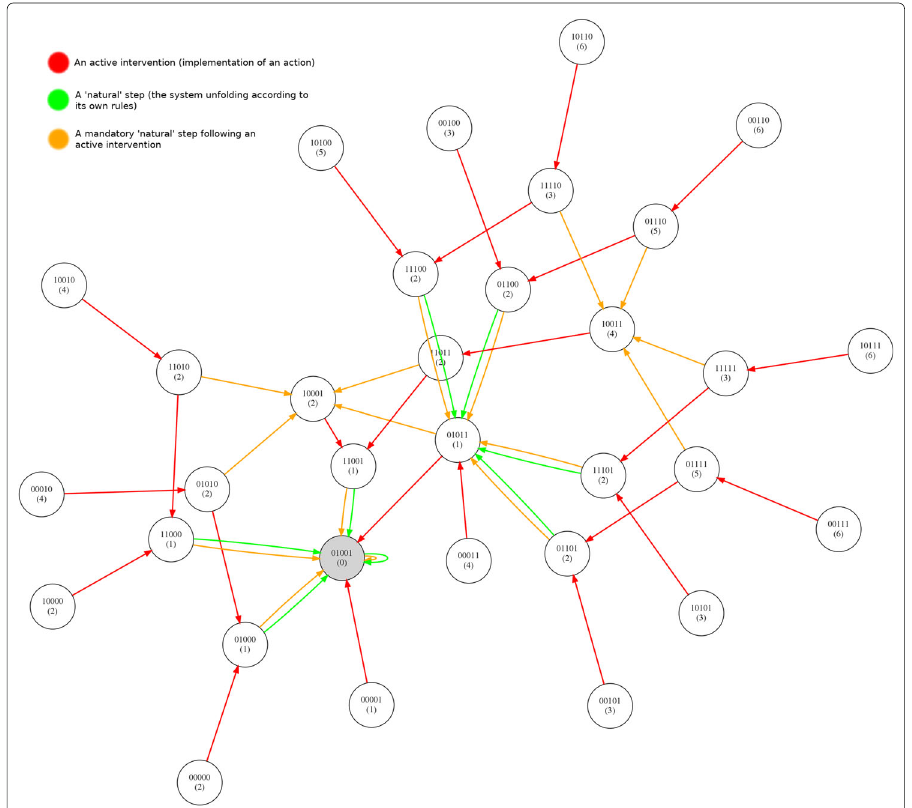
Fig. 11 An example control graph for NK Boolean Network 4 using an evolved rule set